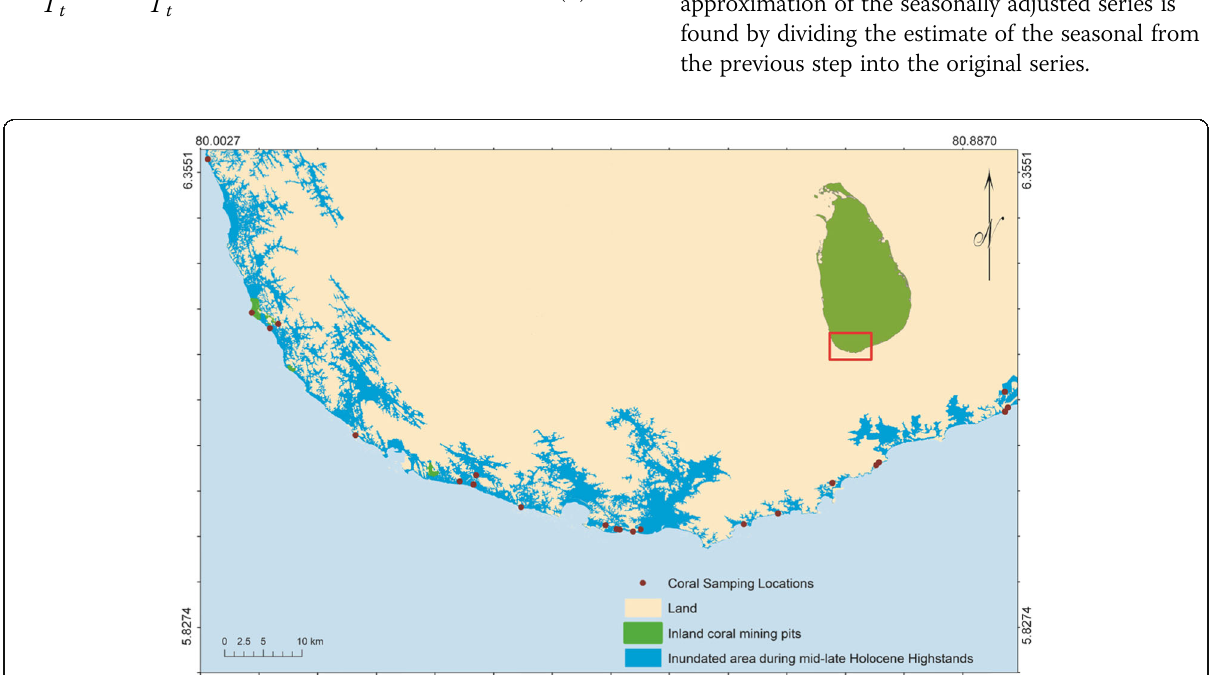
Fig. 2 Map of the study area showing the area for observed and estimated middle Holocene sea-level inundation based on paleo sea-level indications and